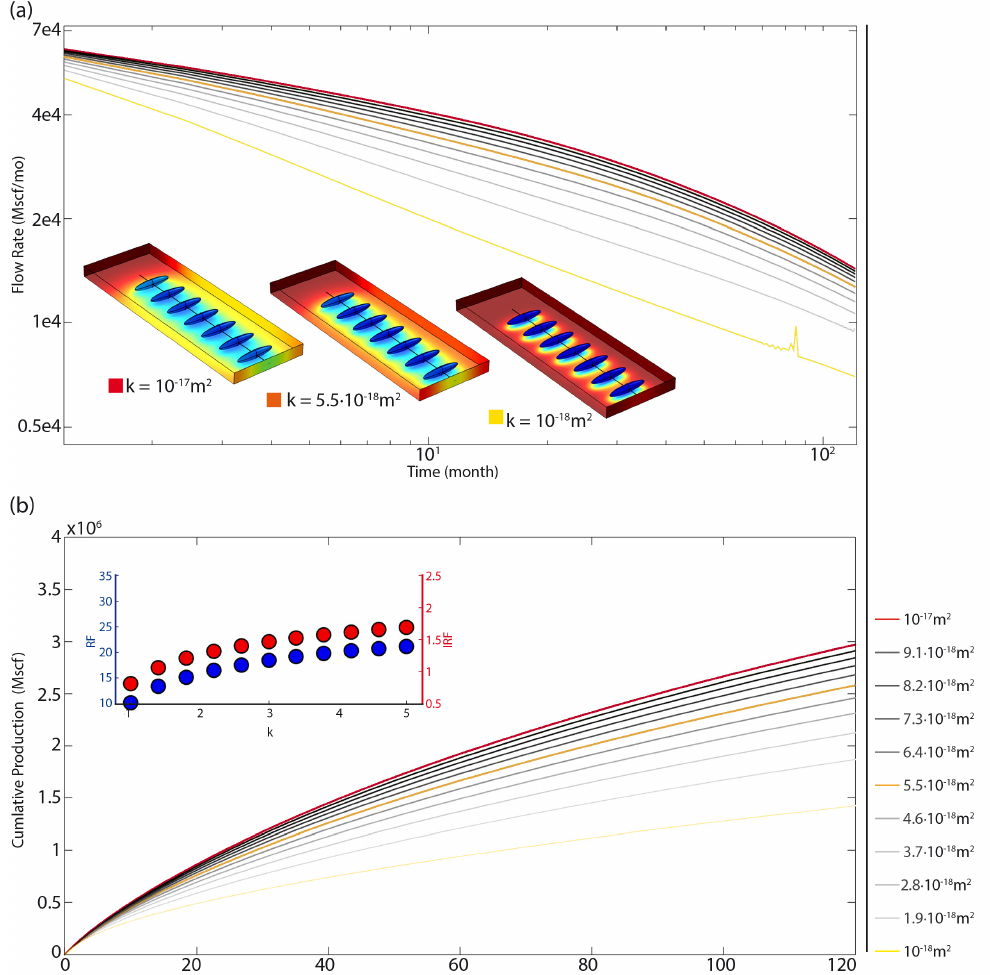
Figure 6. Impact of permeability. Flow rate production of methane in log-log scale. The snapshots represent the BCa field pressure for different permeability values in the SRV ( a ). Cumulative production of methane in log-log scale ( b ). Ten year simulation. Field pressure colormap takes the value range that appears in the Figure